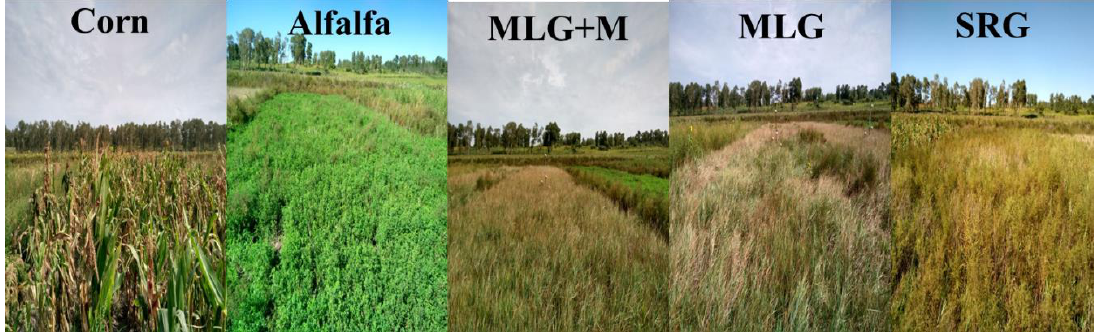
Figure 2. Images of the land use treatments in this study. Corn, corn cropland; Alfalfa, alfalfa forage land; MLG, monoculture grassland; MLG + M, monoculture grassland for hay (Mowing); SRG, successional regrowth grassland.